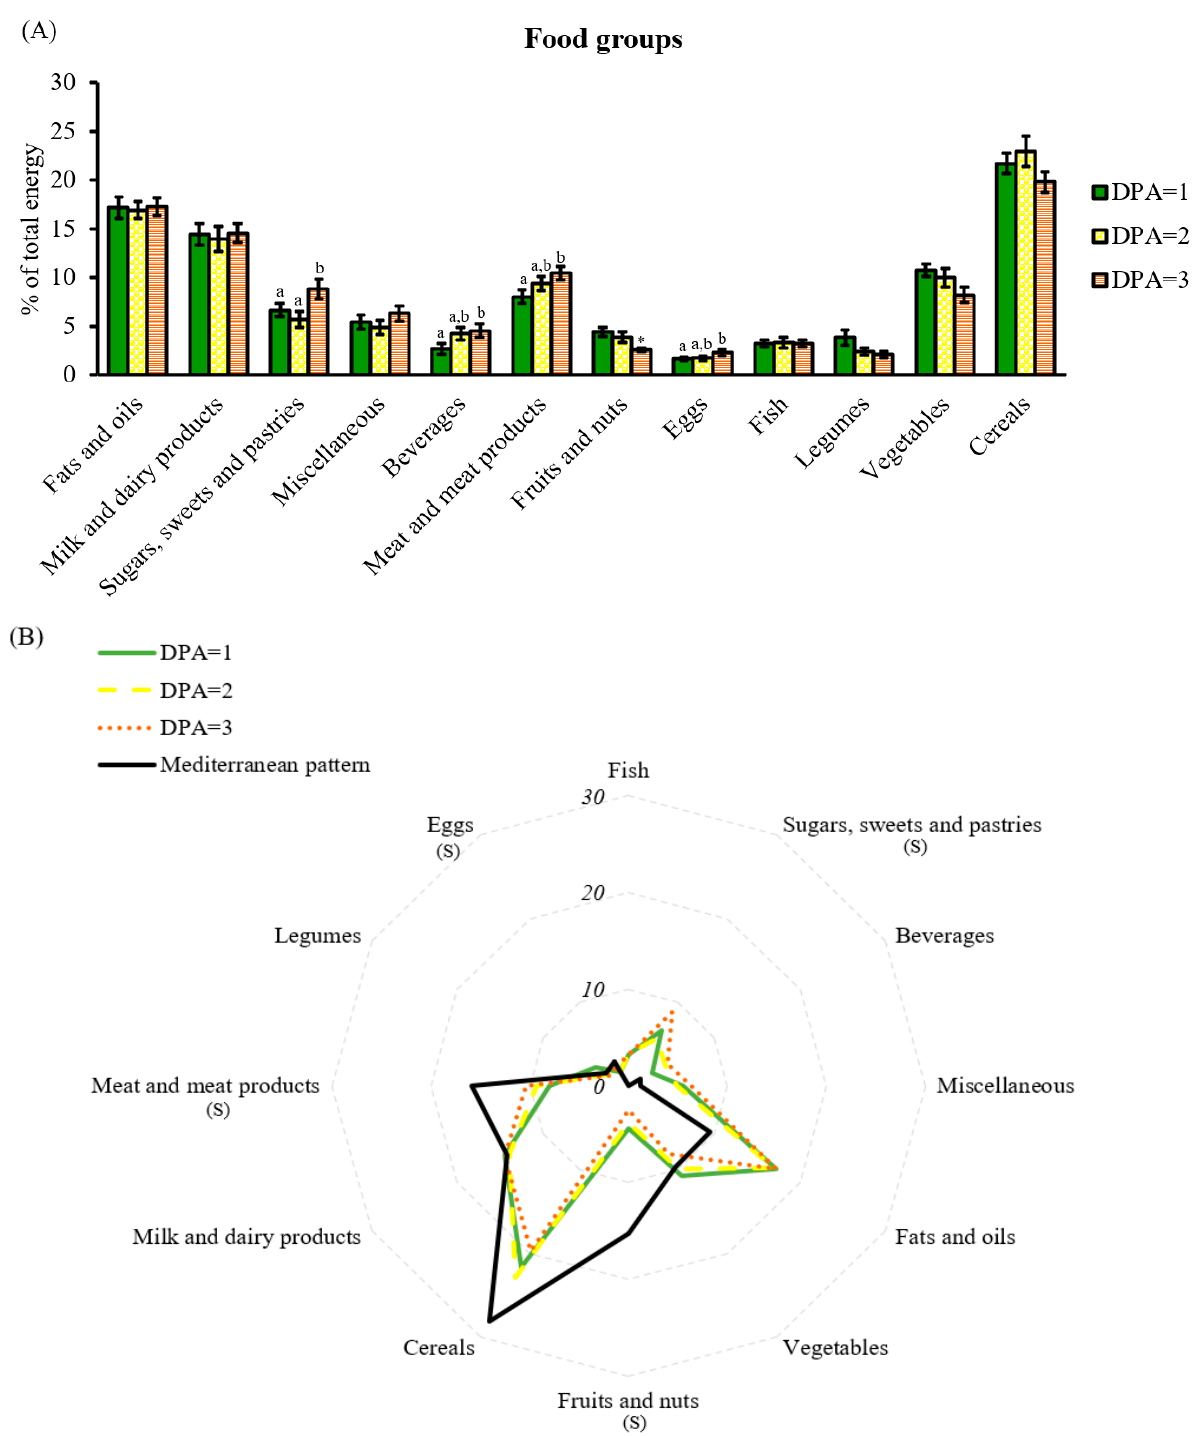
Figure 6. Food group analysis by DPA score. ( A ) Percentage of total energy coming from food groups classified by DPA score; ( B ) comparison of the reference food groups based on the Mediterranean diet with the food groups shown in the cohort and classified by DPA score. Data are mean ± SEM DPA scores 1, 2, and 3 ( n = 23, 18, and 18, respectively). Statistics: ( A ) groups with different letters are significantly different (LSD post hoc one-way ANOVA, p -value ≤ 0.05); if not significant, single comparisons between DPA = 1 and DPA = 2 or 3 were assessed by Student’s t -test (*, p -value ≤ 0.05); ( B ) S, differences between DPA scores and Mediterranean diet (one-way ANOVA, p -value ≤ 0.05). Abbreviations: DPA: diet profiling algorithm.